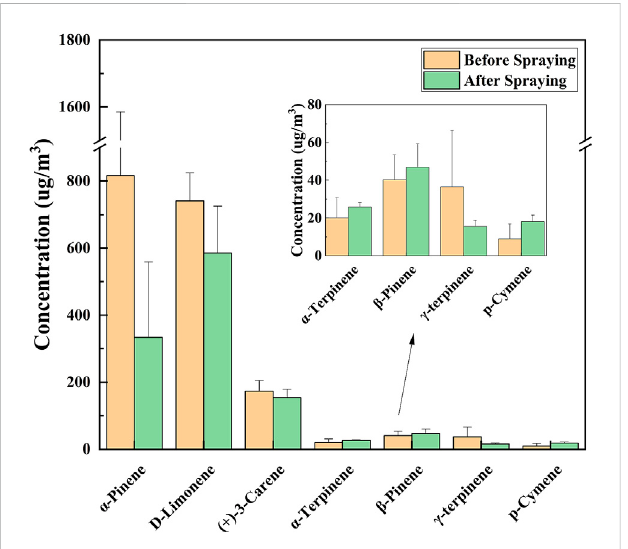
FIGURE 7 Changes in terpene compounds before and after spraying.